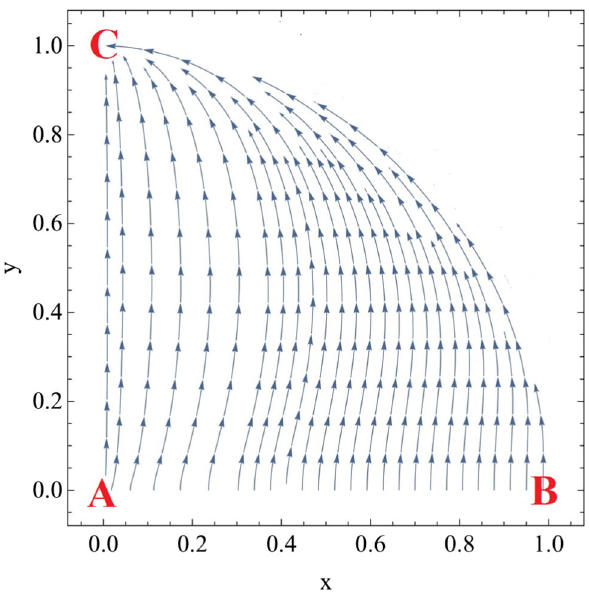
Fig. 1 The stream plot for a universe with dark matter, dynamical dark energy (cid:2)( a ) and the quadratic term from the CCGG equations. The x refers to the matter part and the y refers to the dark energy density. The figure shows that the matter domination (B) is an unstable point and the dark energy domination (C) is a stable